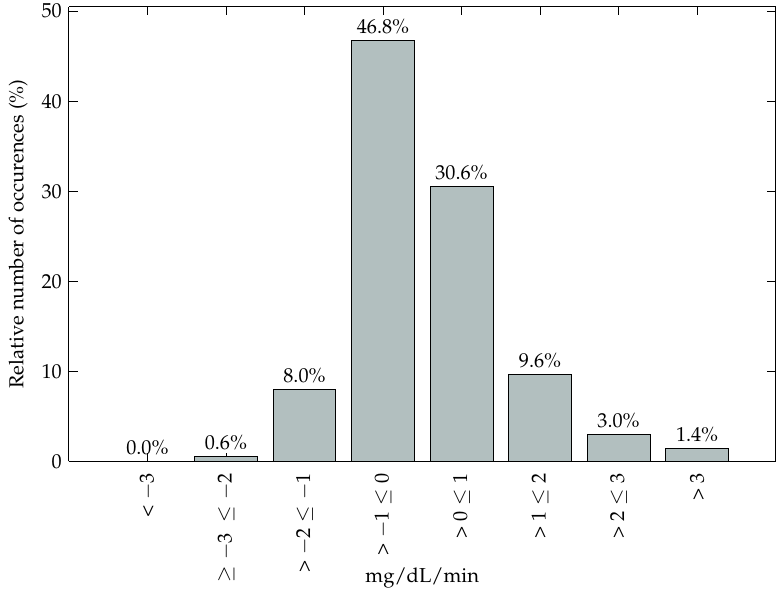
Figure 6. Glucose rate of change during